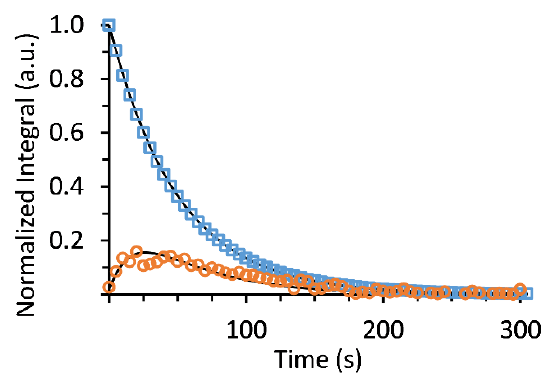
Figure 4. Kinetic model fit of the hyperpolarized signals of [1- 13 C]pyruvate and [1- 13 C]lactate obtained